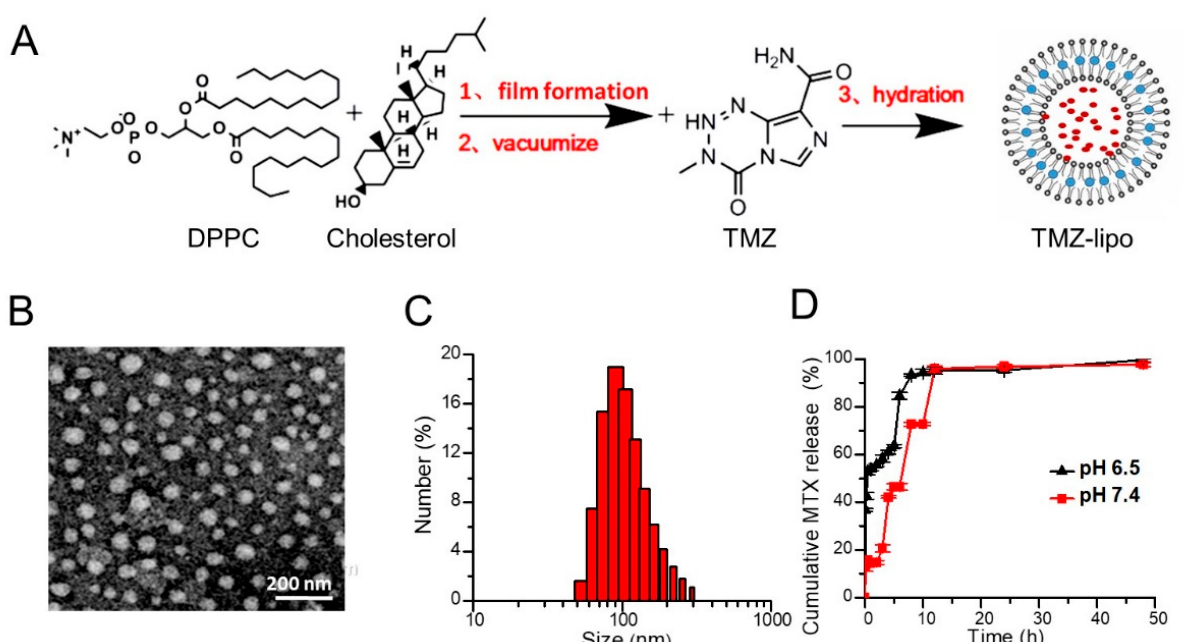
Figure 1. Fabrication and characterization of the TMZ-lipo. ( A ) Schematic diagram of the fabrication of TMZ-lipo. ( B ) Representative micrograph obtained by transmission electron microscopy. Scale bar = 200 nm. ( C ) Particle size distribution of the TMZ-lipo obtained by dynamic light scattering. ( D ) In vitro drug release profile of TMZ-lipo in PBS at pH 6.5 and pH 7.4 ( n = 3).